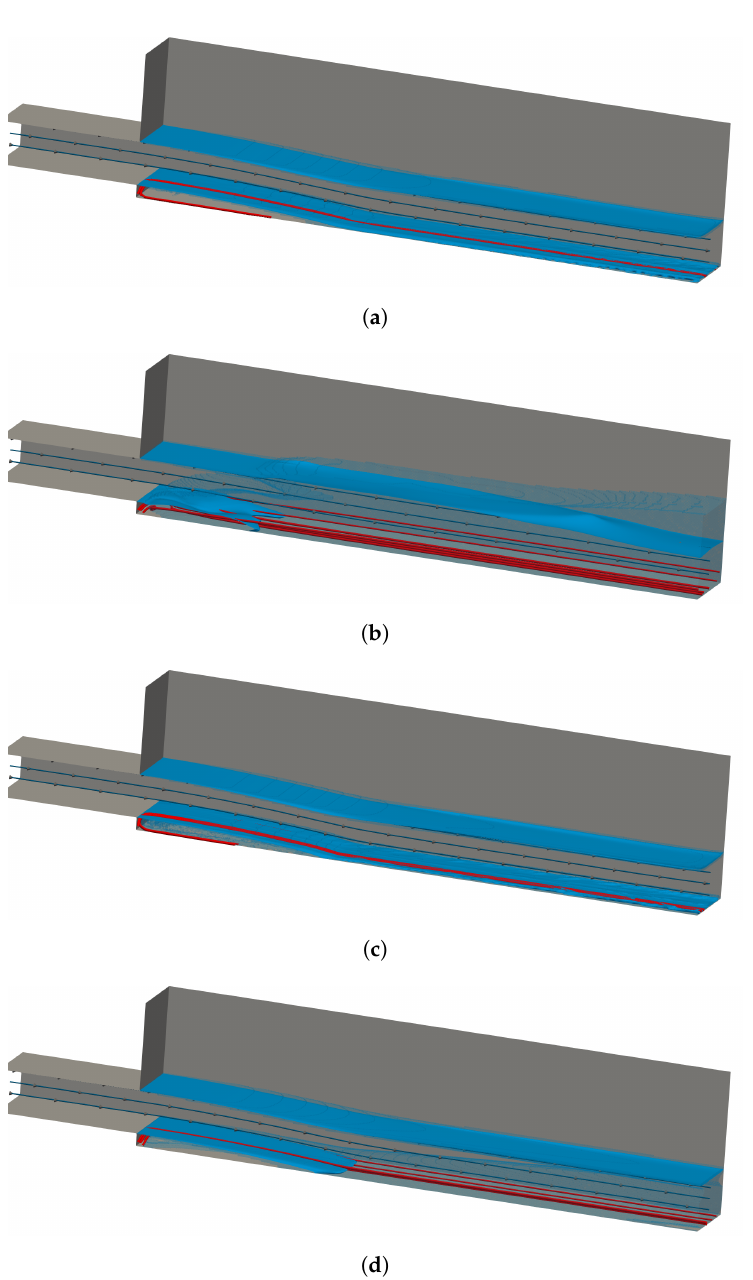
Figure 3. 3D flow—surface ( α = 0.5, solid blue), interface region (0.01 < α < 0.99, transparent blue), air vents streamlines (red), water inlet streamlines (dark-blue) ( R m = 40, except R m = 30 for CTPE k – (cid:101) mixture ). ( a ) TPVoF , k – (cid:101) . ( b ) CTPE , k – (cid:101) mixture . ( c ) TPVoF , k – ω SST . ( d ) CTPE , k – ω SST Sato